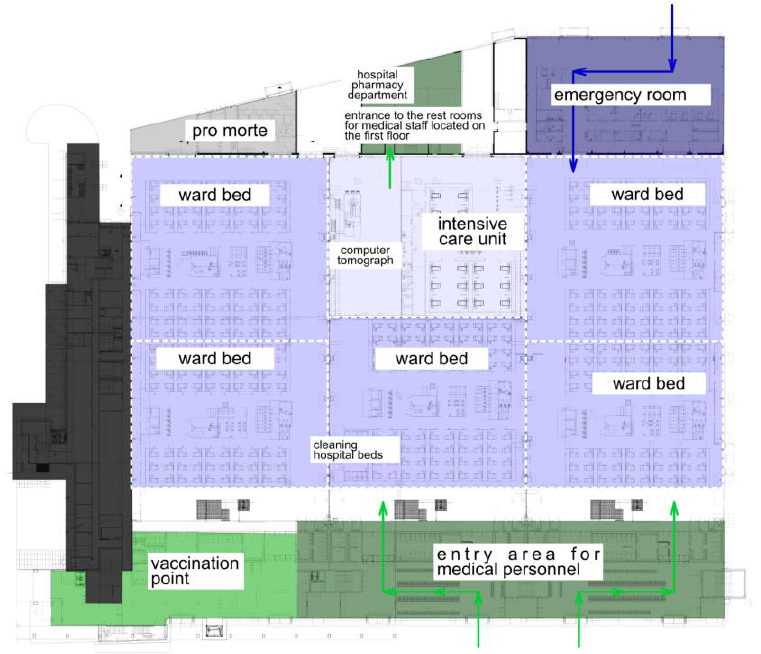
Figure 3. Functional and spatial layout diagram for the AmberExpo temporary hospital in Gdansk